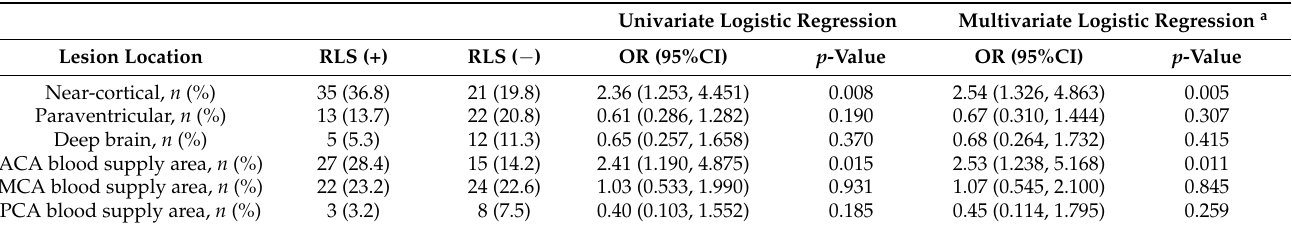
Table 4. Comparison of white matter lesions between the RLS-positive group and the RLS-negative group. Univariate Logistic Regression Multivariate Logistic Regression a